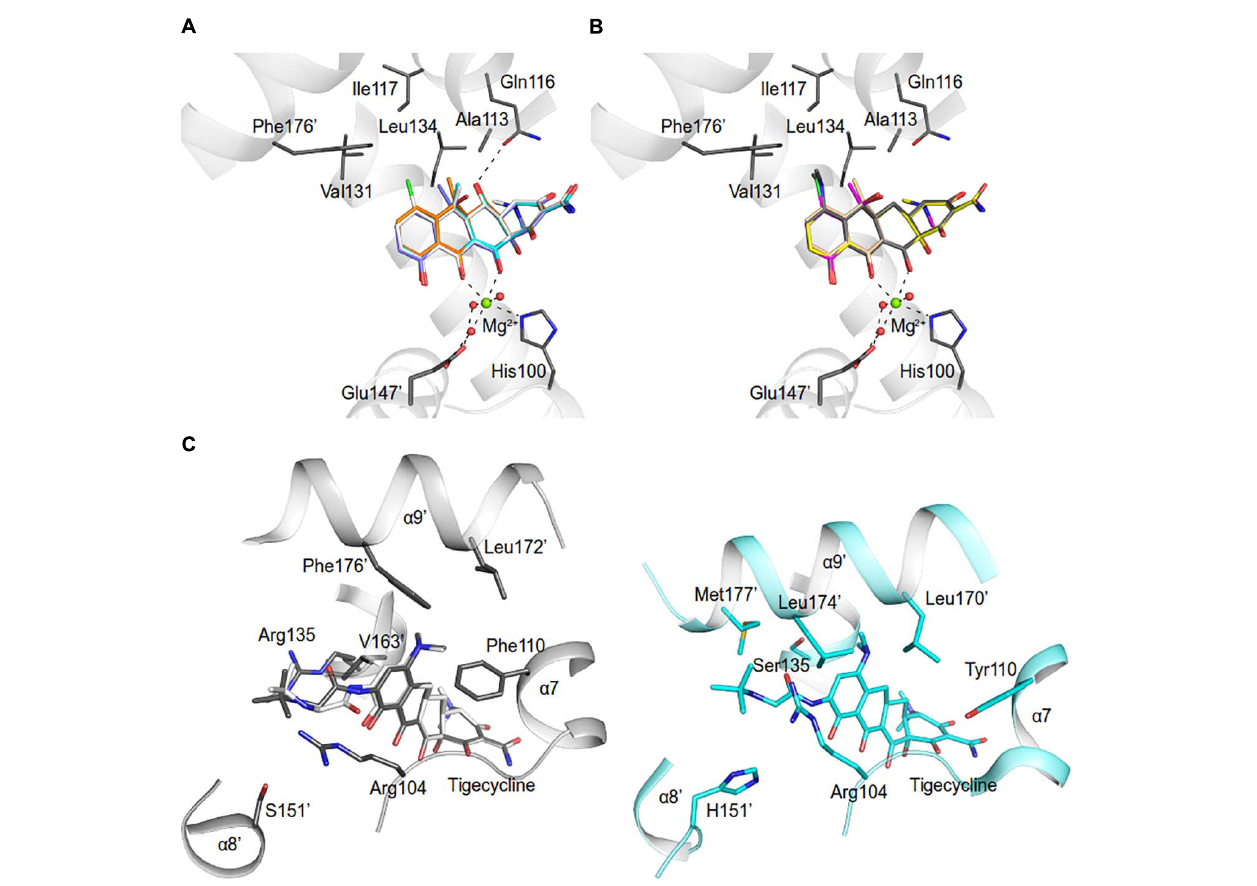
FIGURE 7 | Model of tetracycline antibiotics in the AbTetR binding pocket. Tetracycline antibiotics and Q116 were modeled to the AbTetR structure. Only residues (except for H100 and E147’) that are involved in the interaction with C5, C6, and C7 of tetracyclines are shown as black sticks. Water molecules are depicted as red spheres. Tetracyclines are shown as sticks (A) Carbon colored as orange: doxycycline; white: meclocycline; cyan: methacycline; slate: oxytetracycline. (B) Carbon colored as magenta: chlortetracycline; yellow: demeclocycline; gray: minocycline; and wheat: tetracycline. (C) Tigecycline binding site of TetR(D) (PDB: 4ABZ) (right) and AbTetR (left). Two tigecycline binding modes were modeled to the AbTetR structure. For clarity, only residues that are involved in the interaction with ring D of tigecycline are